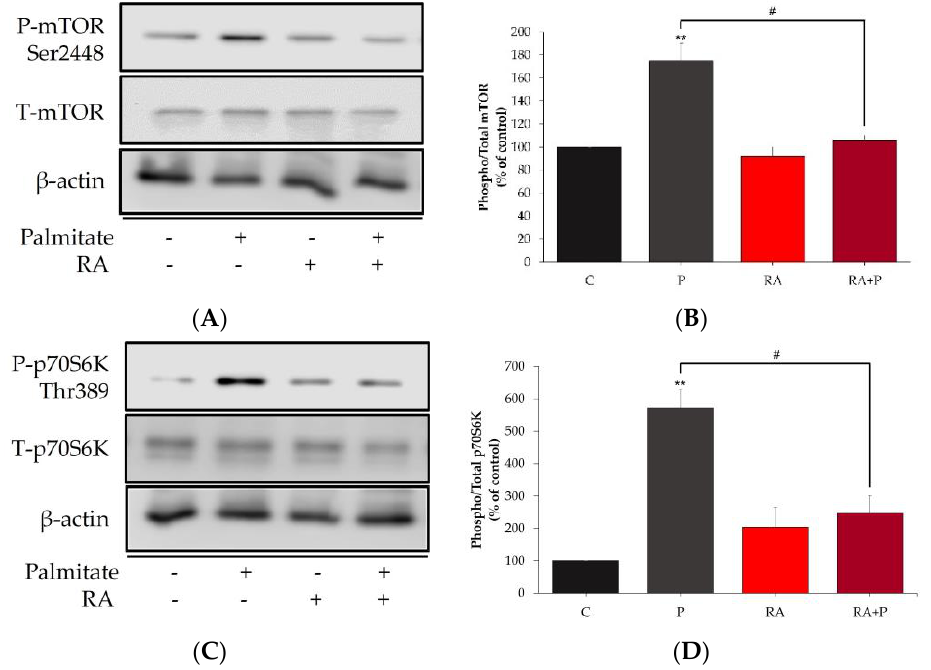
Figure 5. Rosmarinic acid prevents palmitate-induced mTOR ( A , B ) and p70S6K (C,D) phosphory- lation/activation. Fully differentiated myotubes were treated without (control, C) or with 0.2 mM palmitate (P) for 16 h in the absence or the presence of 5 μM rosmarinic acid (RA). After treatment, the cells were lysed, and SDS-PAGE was performed, followed by immunoblotting with specific antibodies that recognize phosphorylated Ser 2448 or total mTOR ( A , B ), and phosphorylated Thr 389 or total p70S6K ( C , D ). Representative immunoblots are shown ( A , C ), and the intensity of the bands (arbitrary units) was measured using Image J software and expressed as percent of control ( B , D ). The data are the mean ± SE of three separate experiments (** p < 0.01 vs. control, # p < 0.05 vs. pal- mitate alone).